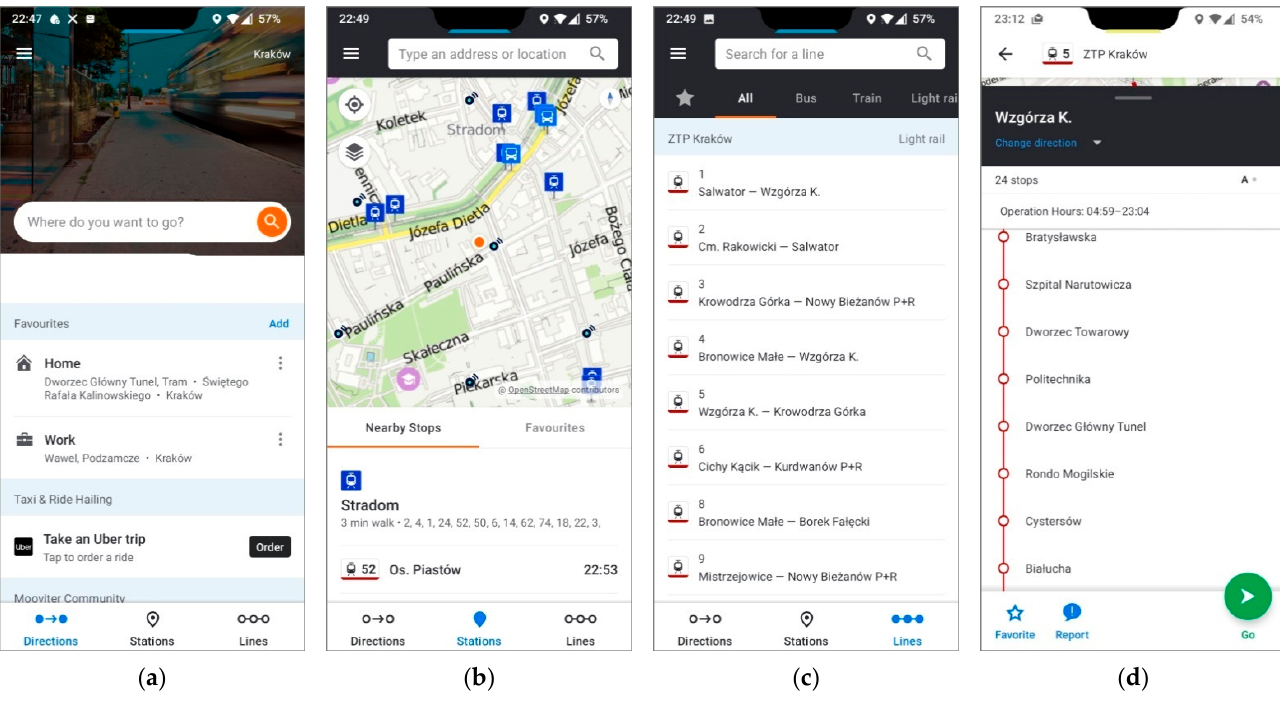
Figure 7. Overview of selected tabs and information windows in Moovit: ( a ) directions ( b ) stations; ( c ) lines; ( d ) proposed route information window.